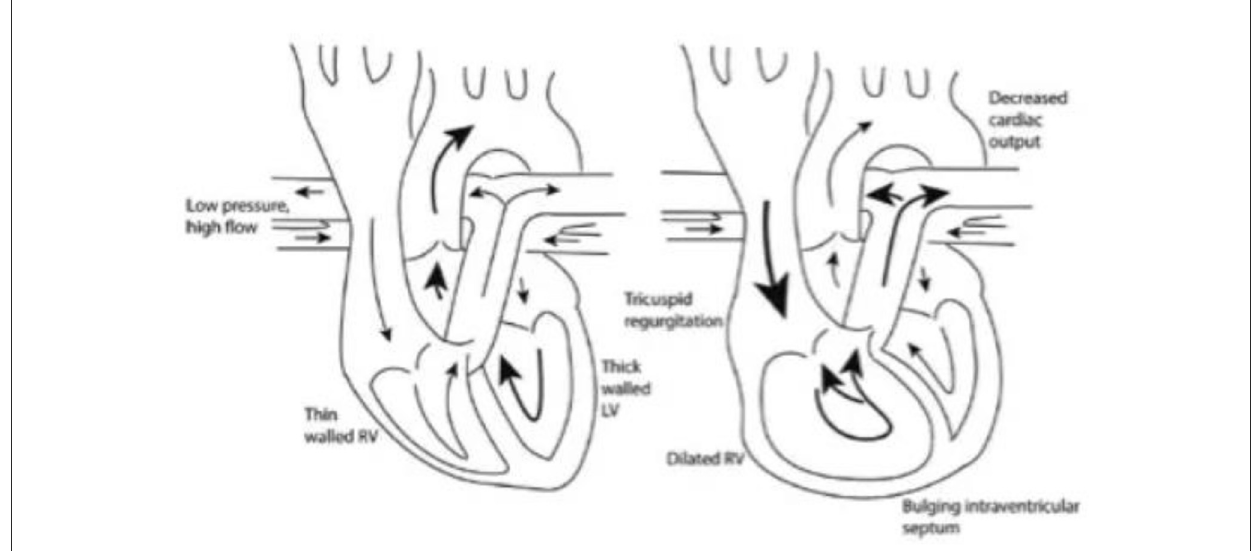
FIGURE2 As the right ventricle dilates and causes bowing into the left ventricle, left ventricular filling is decreased resulting in reduced cardiac output (38).